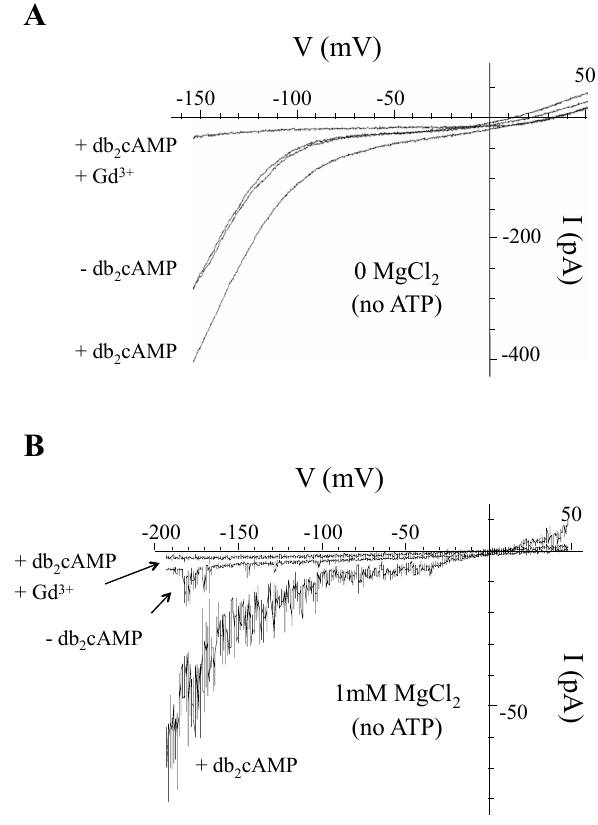
(cid:48) ,5 (cid:48) -cyclic adenosine monophosphate (cAMP) potentiates a Gd 3 + -sensitive current Figure 7. Dibutyryl 3',5'-cyclic adenosine monophosphate (cAMP) potentiates a Gd 3+ -sensitive current Figure 7. Dibutyryl 3 in guard cells either in the presence or absence of intracellular Mg 2 + . Experiments were conducted in the whole cell configuration, where the GCPs were held at -52 mV and the I-V plots were generated using a hyperpolarizing ramp protocol. See Methods for bath and intracellular media. ( A ) Typical example from a V. faba GCP patched with no Mg-ATP in the intracellular media, showing